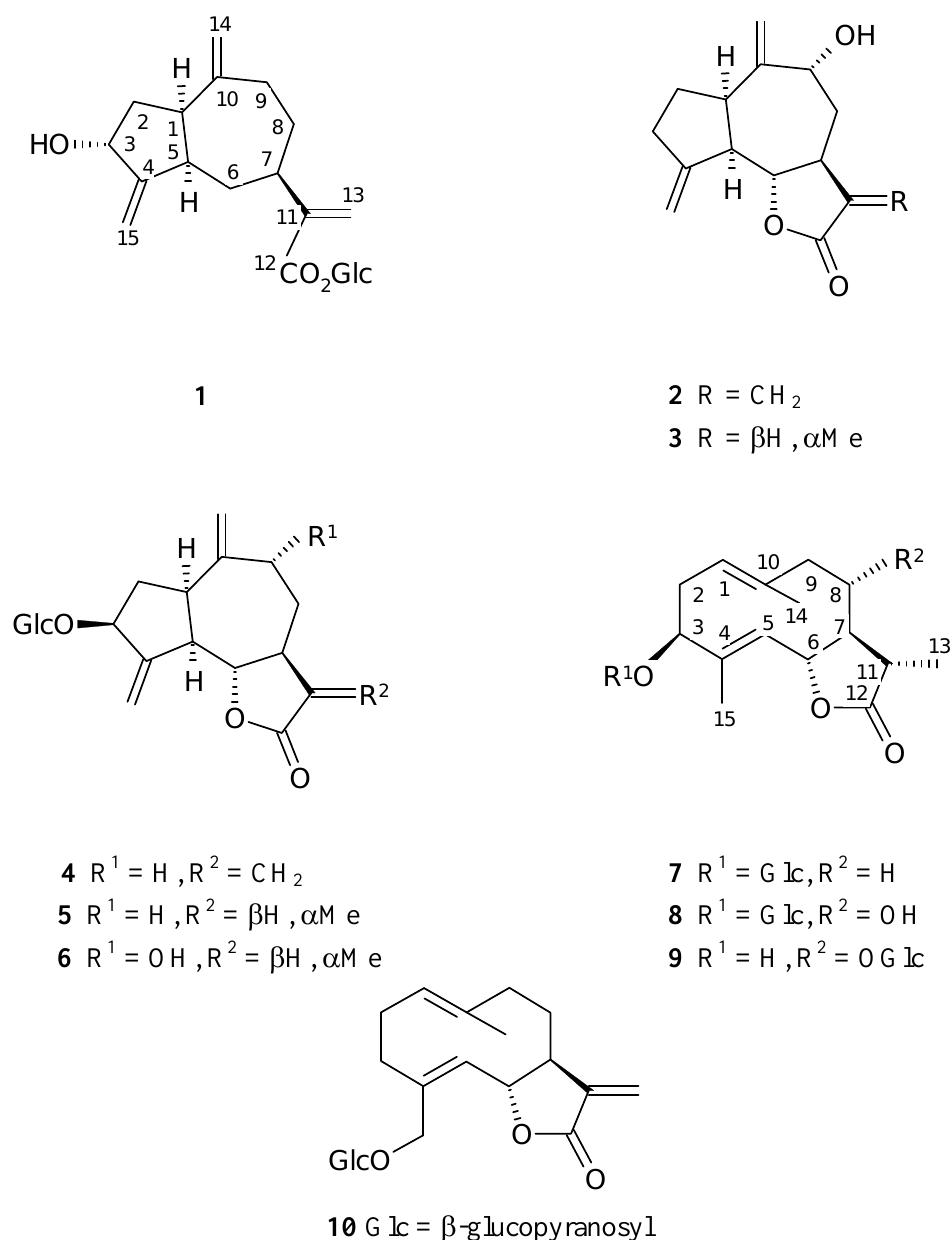
Figure 1. Chemical structures of compounds 1 –